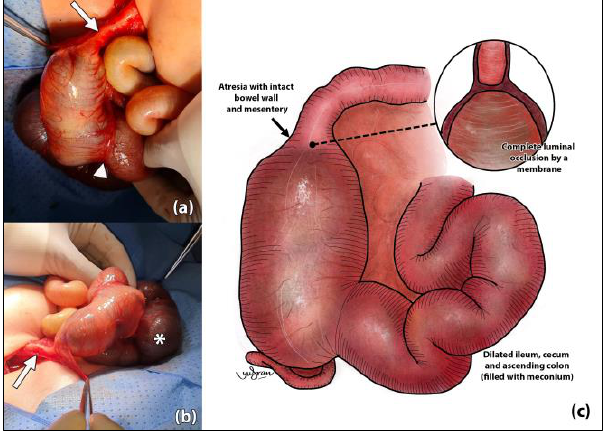
Figure 2: (a, b) Intraoperative findings of colonic atresia at ascending colon with dilated proximal colon and collapsed distal colon (white arrow), wide ileocecal valve (white arrowhead) and dilated distal ileum (white asterisk), (c) illustration to represent the operative findings of type 1 colonic